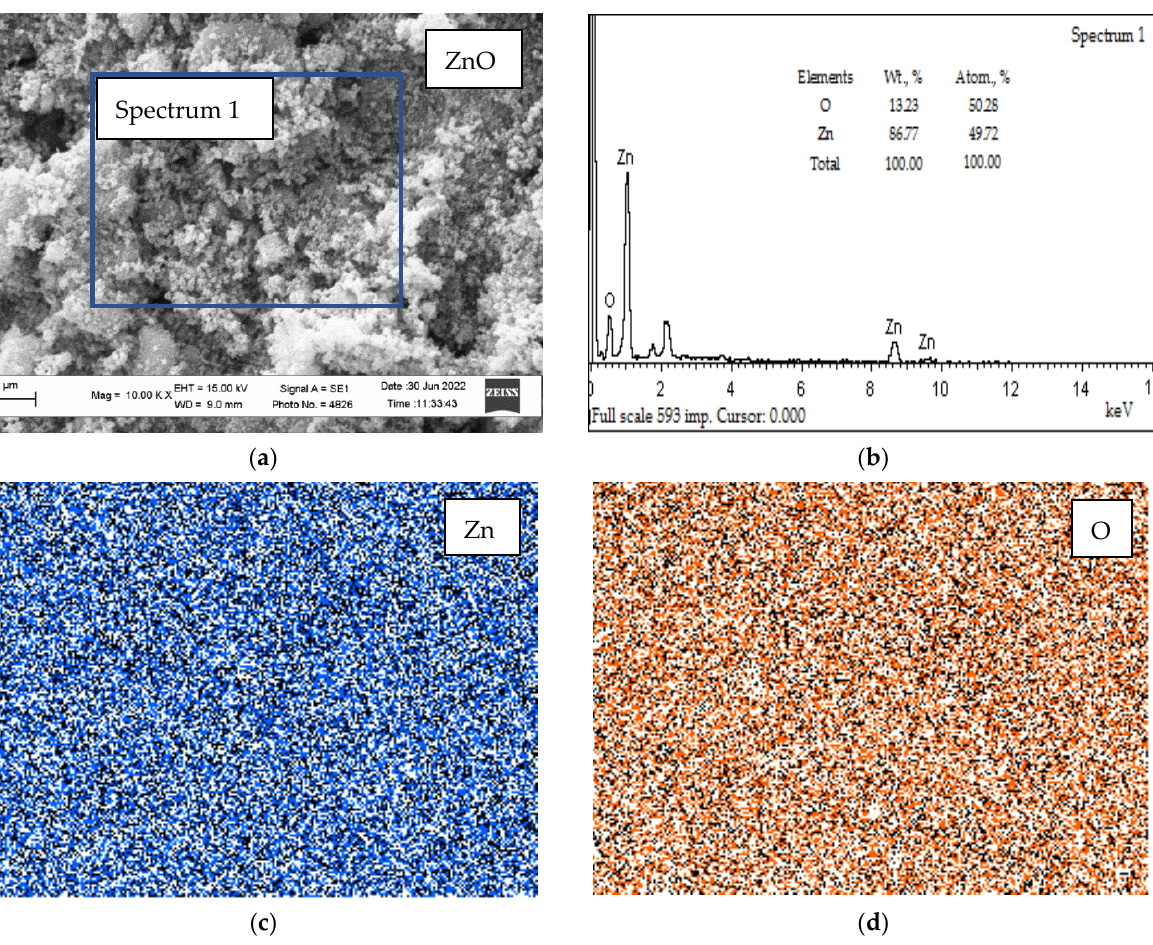
Figure 6. The results of the EDS analysis of ZnO NPs: ( a ) the morphology of the ZnO NPs; ( b ) overall spectrum ZnO NPs; ( с ) distribution of Zn; ( d ) distribution of O.